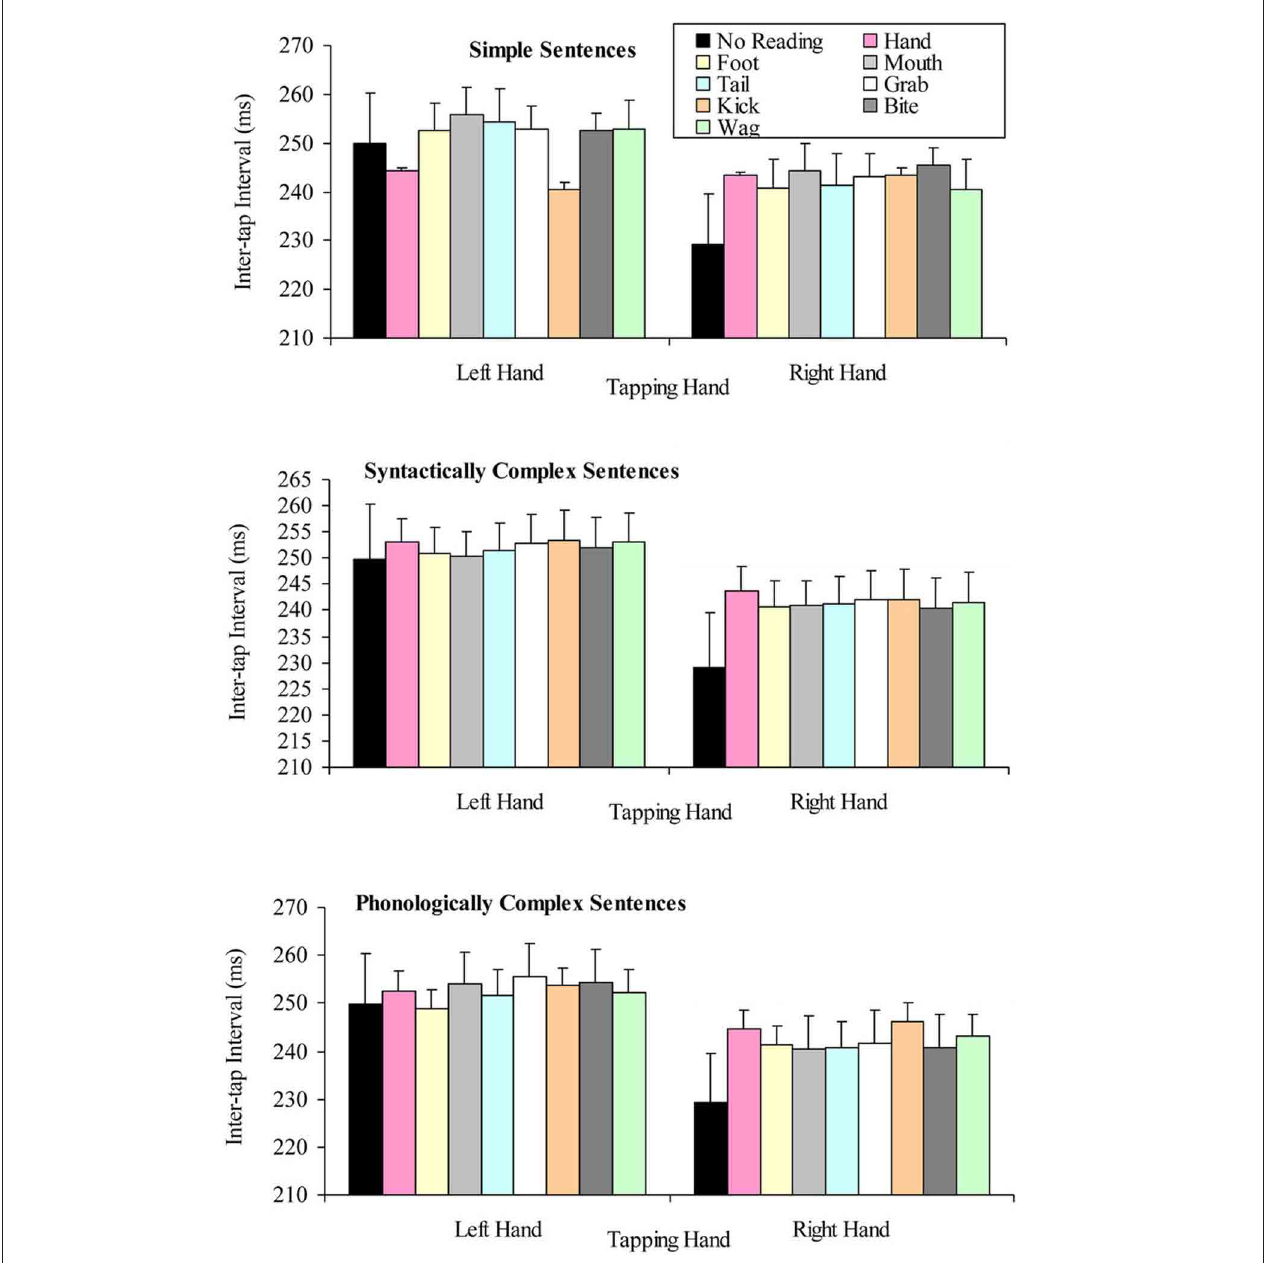
FIGURE 4 | Mean inter-tap intervals for the tapping hand × target word conditions for each type of sentence complexity in the reading aloud data set (error bars represent the standard error of the mean).